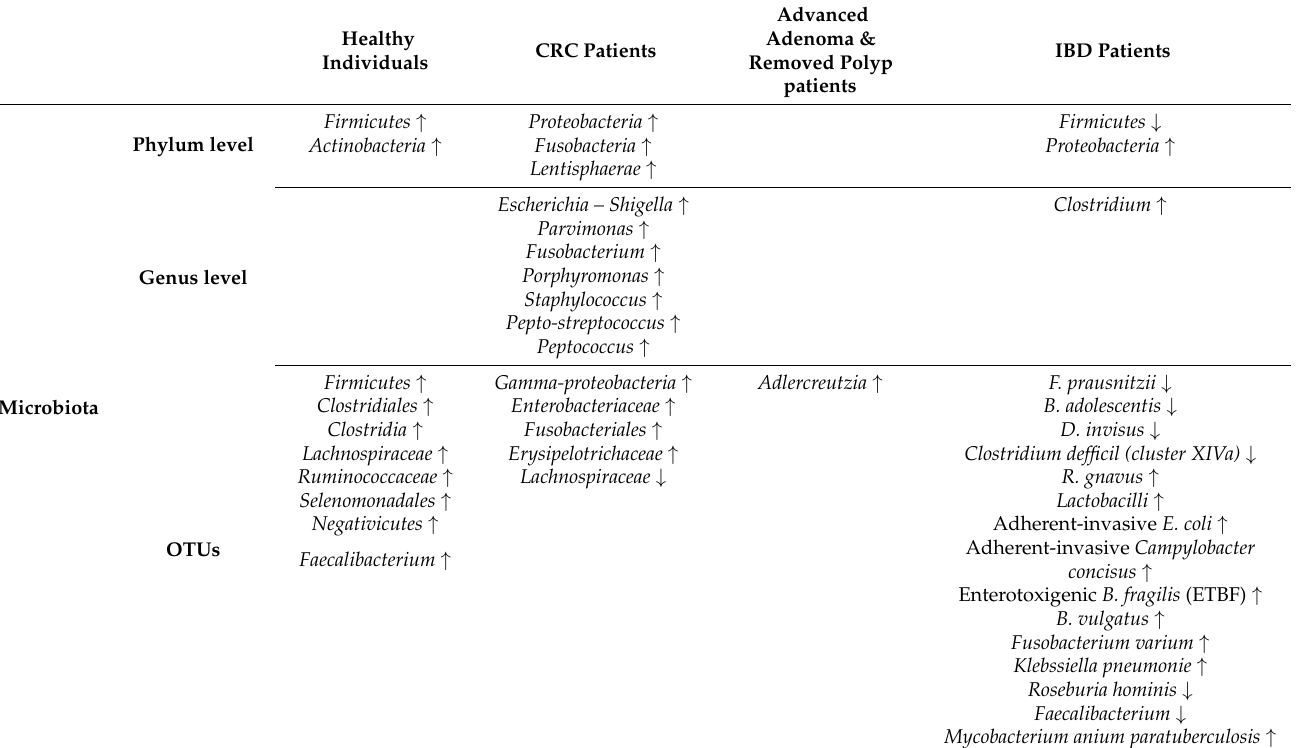
Table 1. Variations in bacteria found in faecal matter between healthy and CRC patients or patients with advanced adenomas and removed polyps, or Inflammatory Bowel Disease (IBD) patients [83–86]. [ ↑ ]: increased abundance, [ ↓ ]: decreased